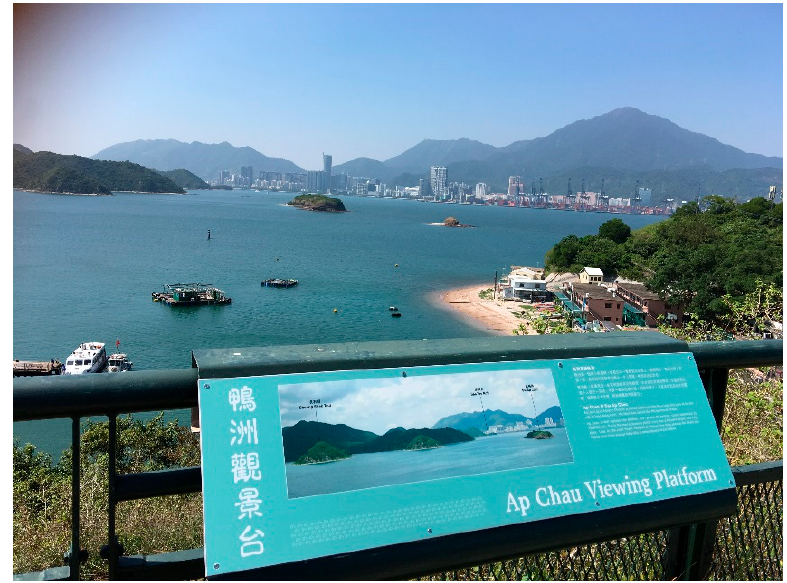
Figure 14. Hong Kong UGGp—View of the island landscape in Hong Kong (China).